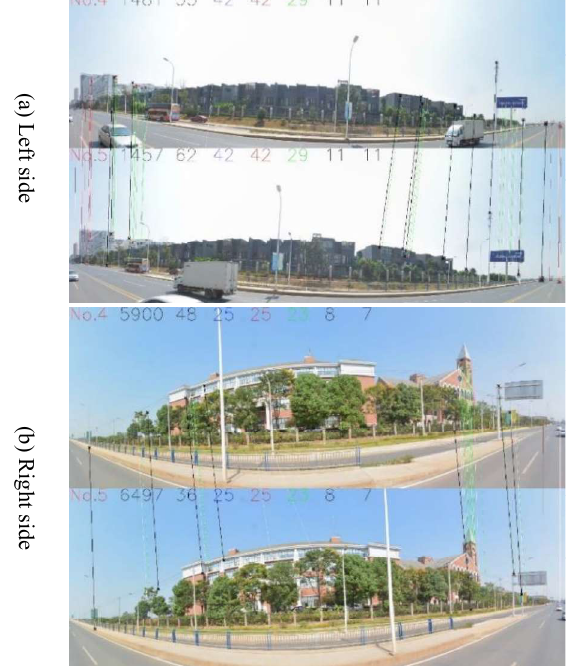
Figure 5 . Feature points matching of No.1-2 in dataset